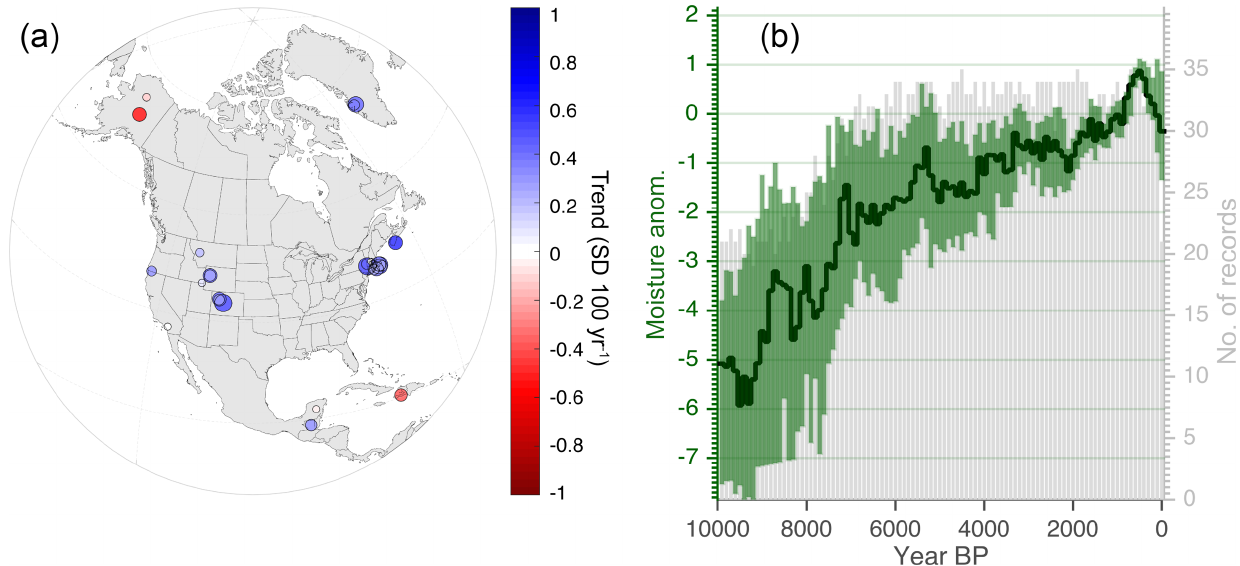
Figure 7. Holocene context including records that extend 6000 years or longer in the North American hydroclimate dataset. Panel (a) shows maps of Holocene-length trends. Blue colors show wetting trends, red colors show drying trends, and the size of the symbol reflects the magnitude of the trend. Panel (b) shows the median Holocene composite of the z scores of the Common Era records (Fig. 1), with 95% bootstrapped confidence intervals. Units represent SD from the mean of the Common Era. Grey bars show the number of available records through time.